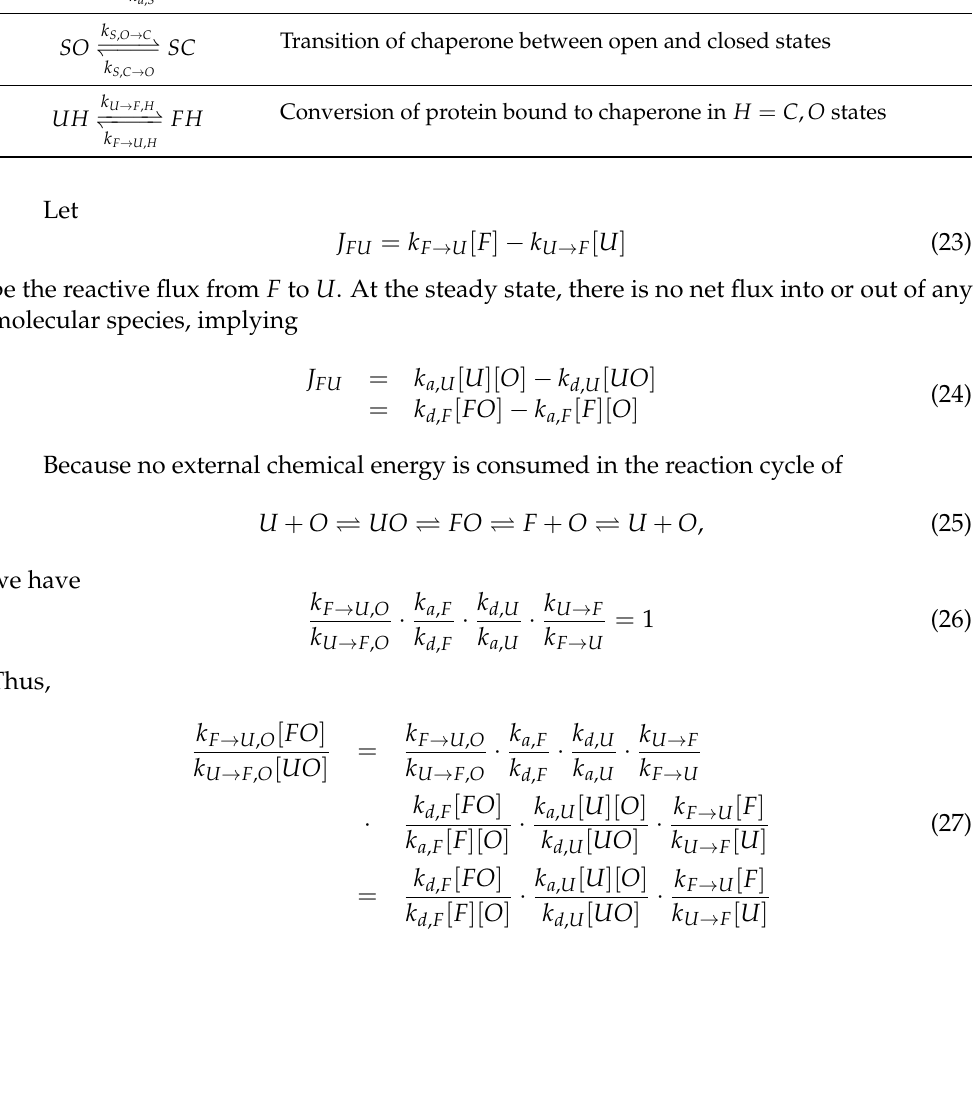
Table 1. The reactions in chaperone-mediated protein folding. These reactions are depicted in Figure 1. ATP hydrolysis and nucleotide exchange occur and inject chemical energy in the chaperone cycle. k U → M −−− (cid:42)(cid:41) −−− U M Misfolding and aggregation; K M = k U → M / k M → U k M → U k U → F −−− (cid:42)(cid:41) −−− U F Transition between intermediate conformations; K F = k U → F / k F → U k F → U k F → N −−− (cid:42) (cid:41) −−− F N Folding to native structure; K N = k F → N / k N → F k N → F k a , S −− (cid:42)(cid:41) −− S + O SO Substrate in S = U , F conformations binding to the open chaperone k d , S k S , O → C −−− (cid:42)(cid:41) −−− SO SC Transition of chaperone between open and closed states k S , C → O k U → F , H −−−− (cid:42)(cid:41) −−−− UH FH Conversion of protein bound to chaperone in H = C , O k F → U , H